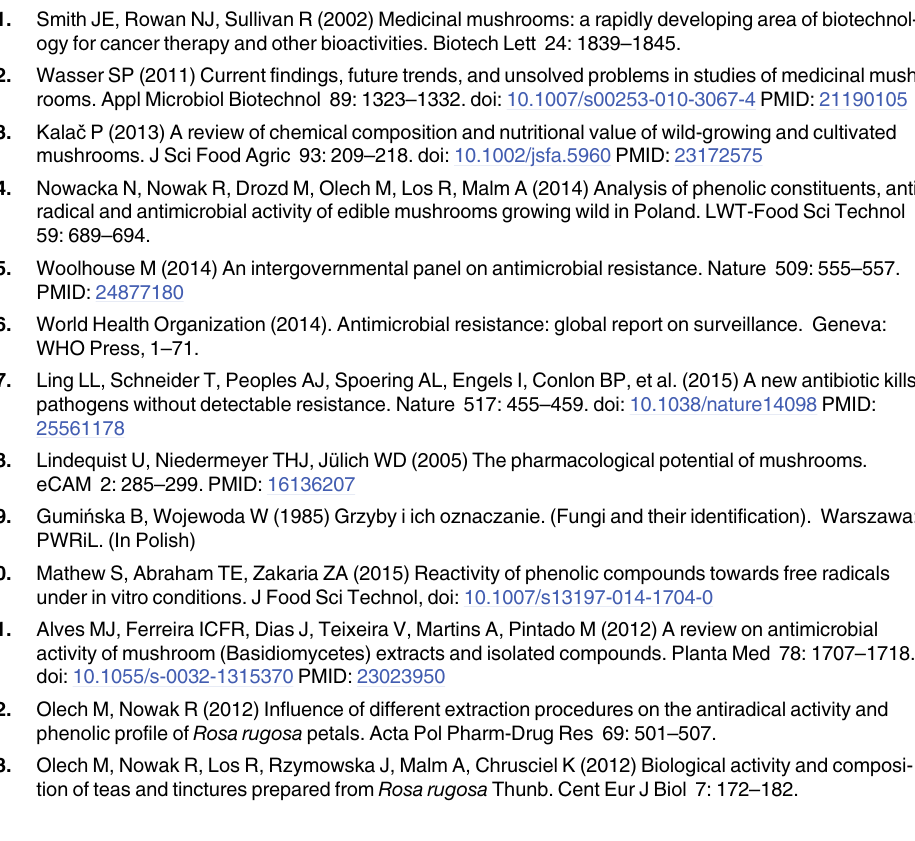
S1 Table. The dose response curves and r2 values used to determine the IC50 values for each